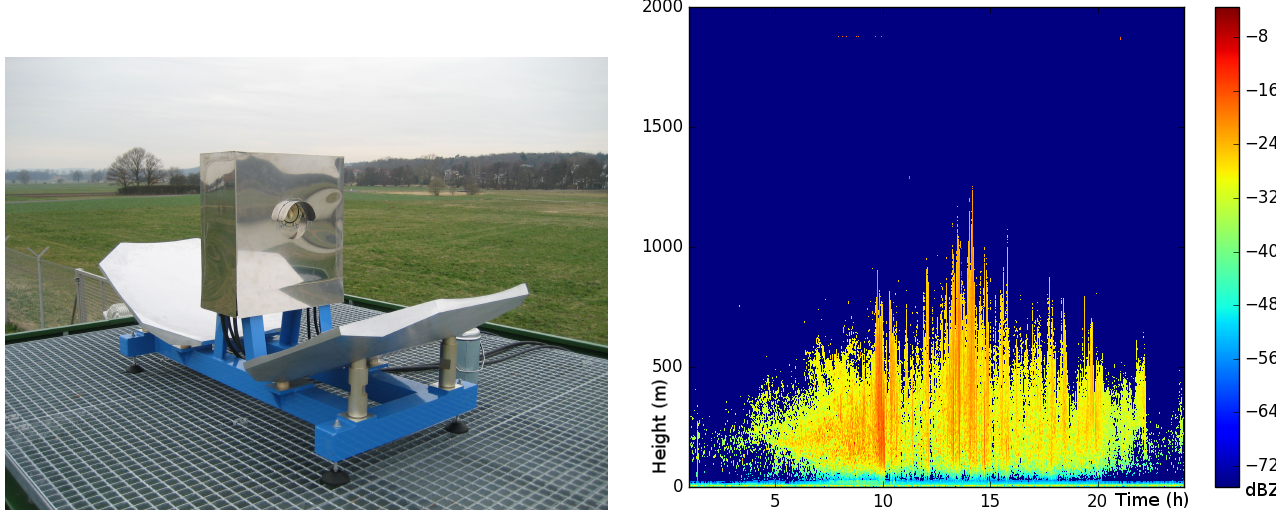
Figure 8. ( left ) operating 94 GHz frequency-modulated continuous-wave (FMCW) cloud radar; ( right ) diurnal